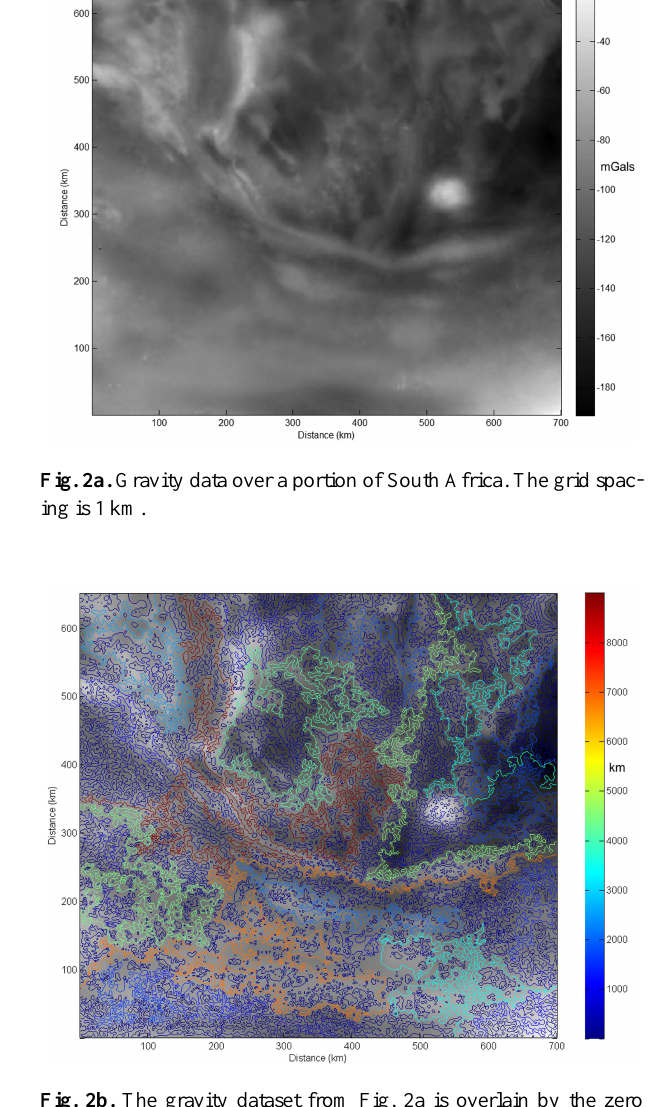
Fig. 2b. The gravity dataset from Fig. 2a is overlain by the zero contour of the Laplacian function. The contours are colour coded by their